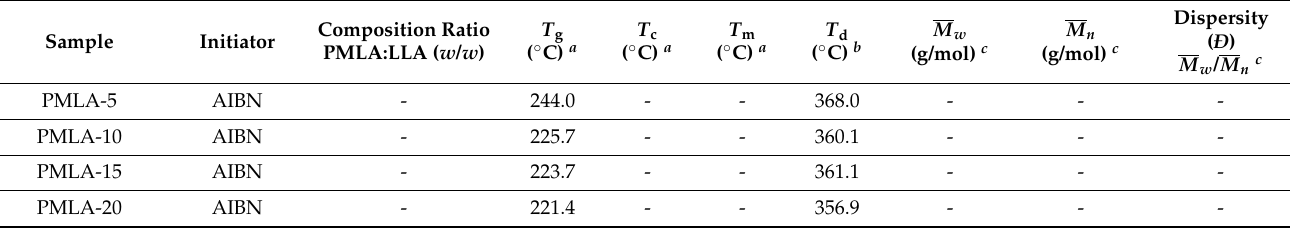
Table 1. Selected characterization data of PMLA, PLA, and P(MLA- g